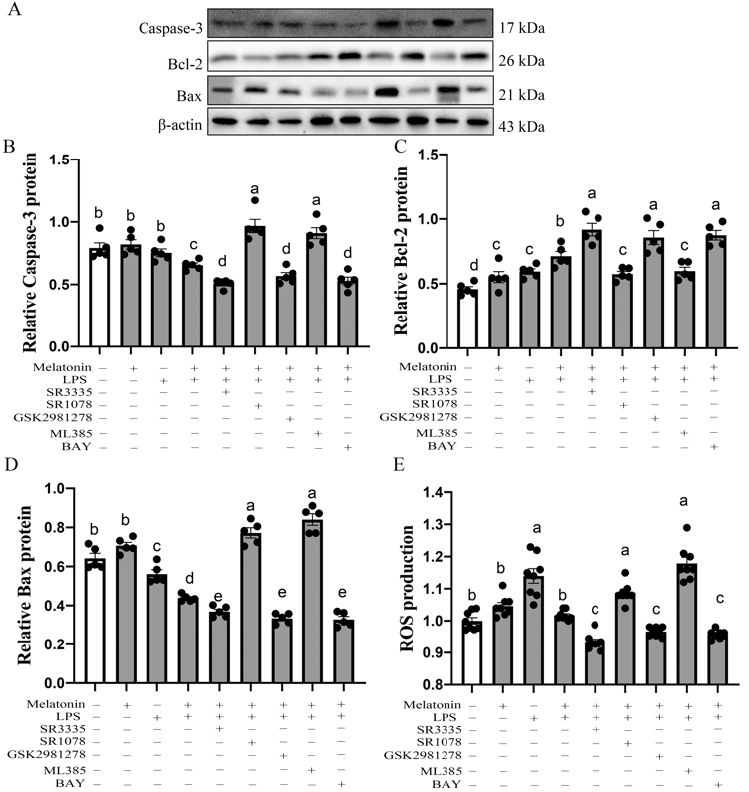
Figure 5. Effects of ROR α antagonists, ROR α agonist, ROR γ antagonist, Nrf2 antagonists and p65 antagonists on Caspase ‐ 3 protein ( A , B ), Bcl ‐ 2 protein ( C ), Bax protein ( D ), ROS level ( E ) of bursal B ‐ lymphocyte in response to LPS in the G → B group. SR3335 is a ROR α antagonist; SR1078 is a ROR α agonist; GSK1981278 is a ROR γ antagonist; ML385 is an NRF2 antagonist; BAY is a p65 antagonist.